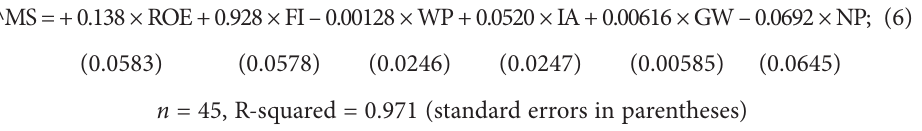
^MS = + 0.138 × ROE + 0.928 × FI – 0.00128 × WP + 0.0520 × IA + 0.00616 × GW – 0.0692 × NP; (6) (0.0583) n = 45, R-squared = 0.971 (standard errors in